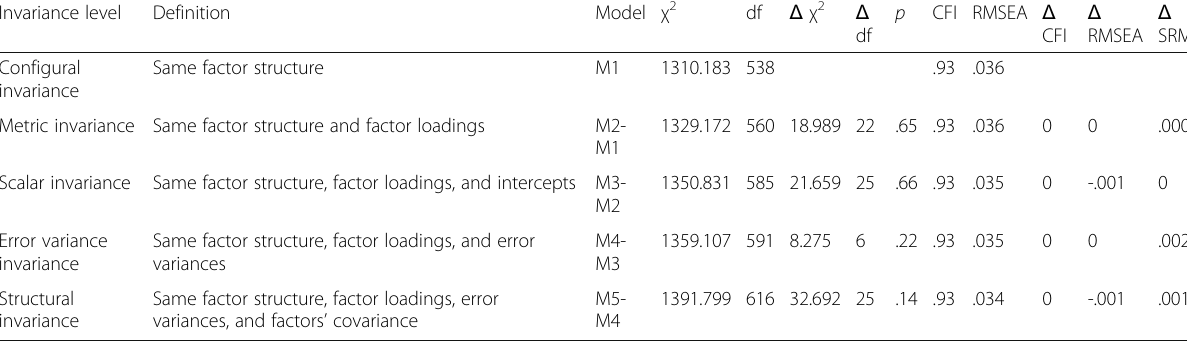
Table 6 Models ’ comparison for invariance tests for URS for samples CFA1 and CFA2) Invariance level